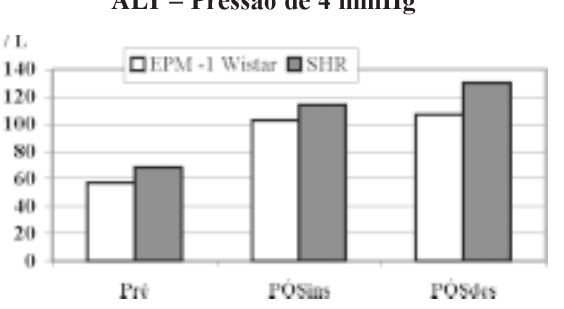
FIGURA 3- N(cid:237)veis sang(cid:252)(cid:237)neos de AST, representados pelas medianas dos valores, para cada linhagem de rato, nos diferentes momentos de avalia(cid:231)ªo, com uma pressªo de 10mmHg de